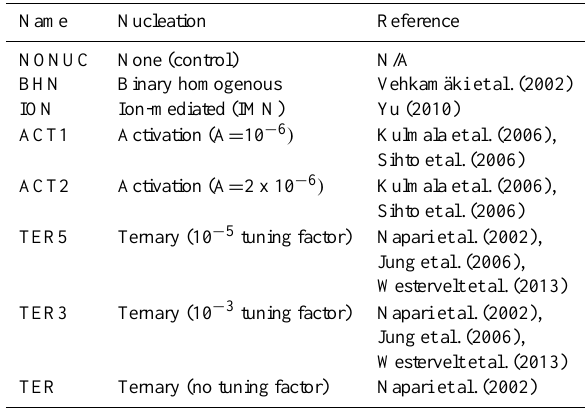
Table 2. List of simulations. All eight simulations were also run at higher SOA production rates, as described in the